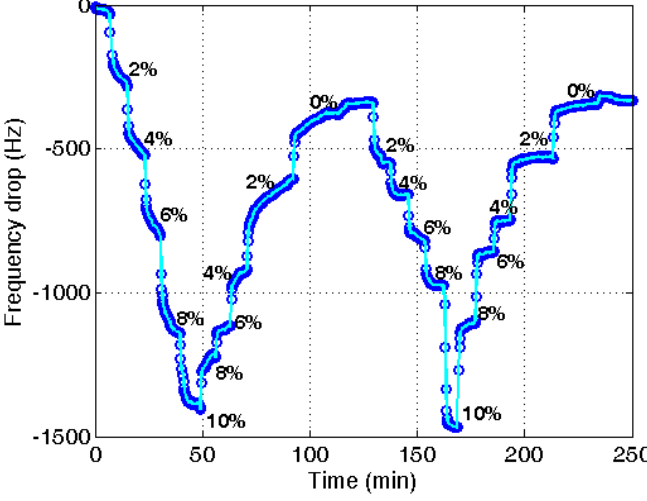
Figure 8. Variation of resonant frequency of a PVA-coated quartz crystal microbalance with increased water content in an in-line measurement.